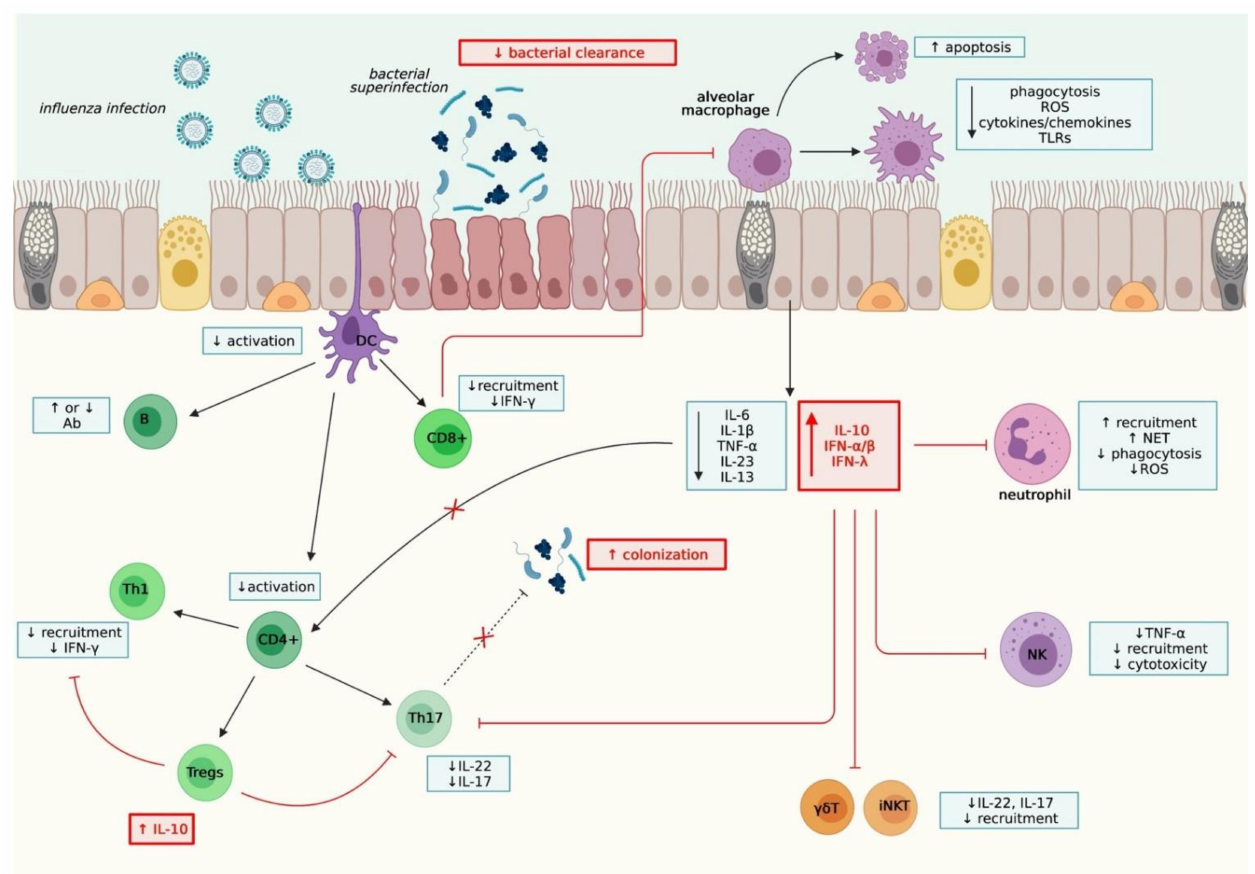
Figure 2. Schematic representation of the immunological mechanisms underlying virus-bacteria co-infections. These mechanisms involve different cell types, in closely related innate and adaptive immune responses. The regulation of the magnitude and timing of these responses plays an essential role in the balance between colonization and bacterial clearance. Created with